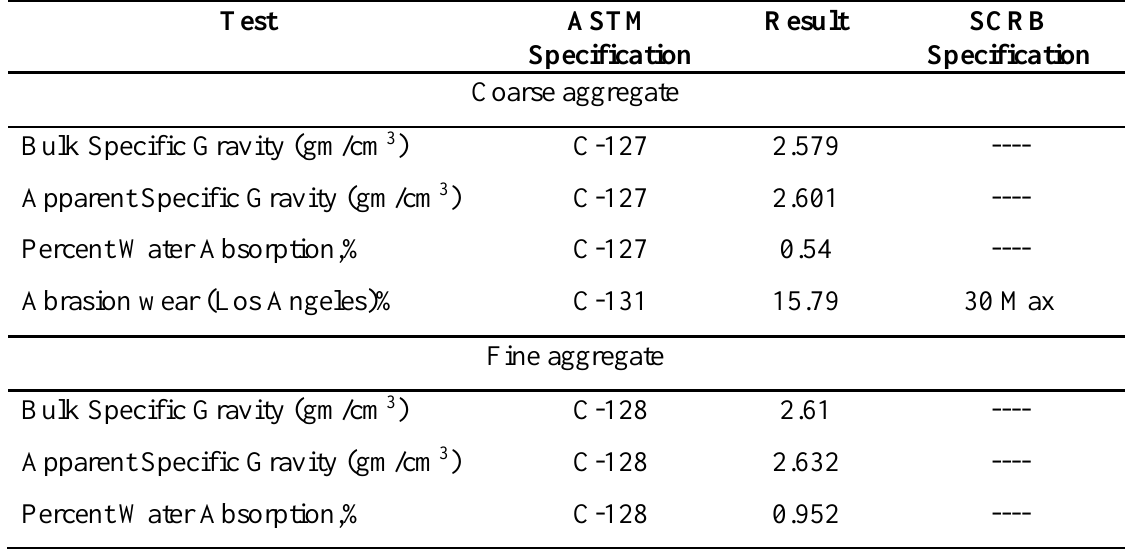
Table. 1. The Properties of Aggregate.